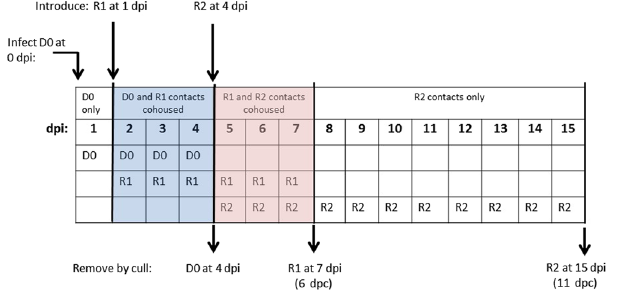
Figure 1. Schematic showing the plan for in vivo transmission of H7N9 LPAIV. Direct-inoculation of D0 (“donor”) birds followed by introduction of two rounds of R1 and R2 (“recipient”) contact birds into each pen, including the planned removal (by culling) of D0 and R1 birds at 4 and 7 dpi respectively. Cohousing periods (3-days) for D0/R1 and R1/R2 birds are indicated by blue and pink shading respectively, with R2 birds intended to remain (unshaded days) to the conclusion of the study at 15 dpi. See Results for subsequent differences from this